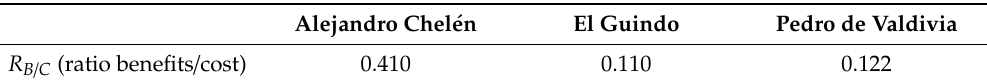
Table 5. Economic